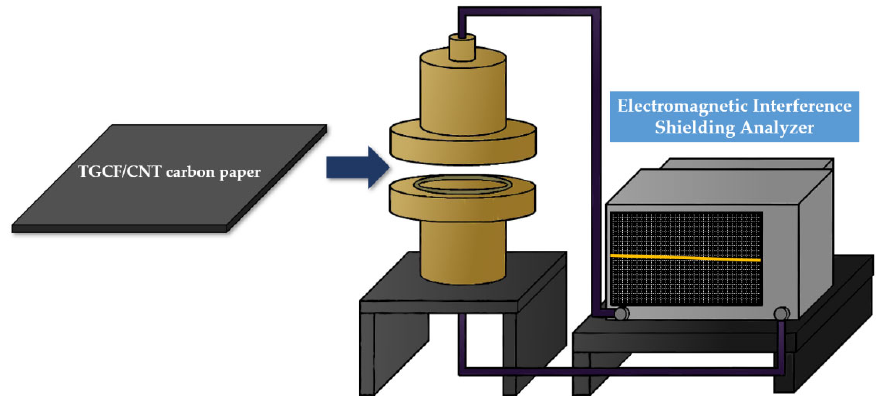
Figure 10. Apparatus of EMI shielding analyzer.